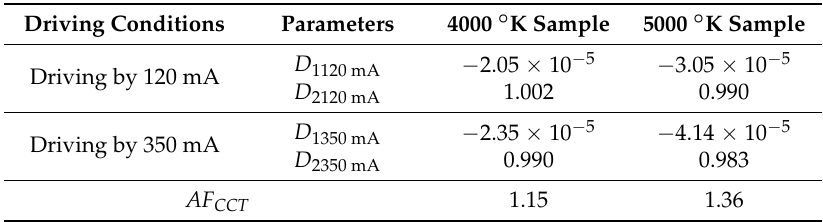
Table 5. Parameters of the linear CCT